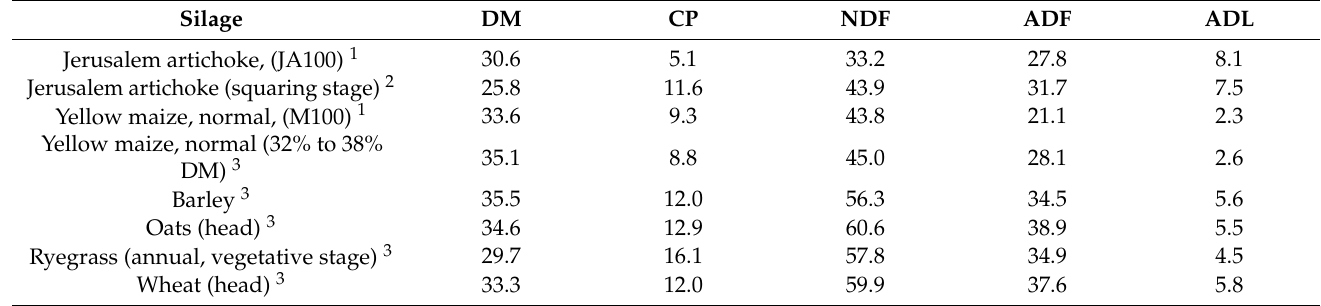
Table 5. Comparison of DM, CP, NDF, ADF and ADL contents in Jerusalem artichoke silages and several main fodder silages (%